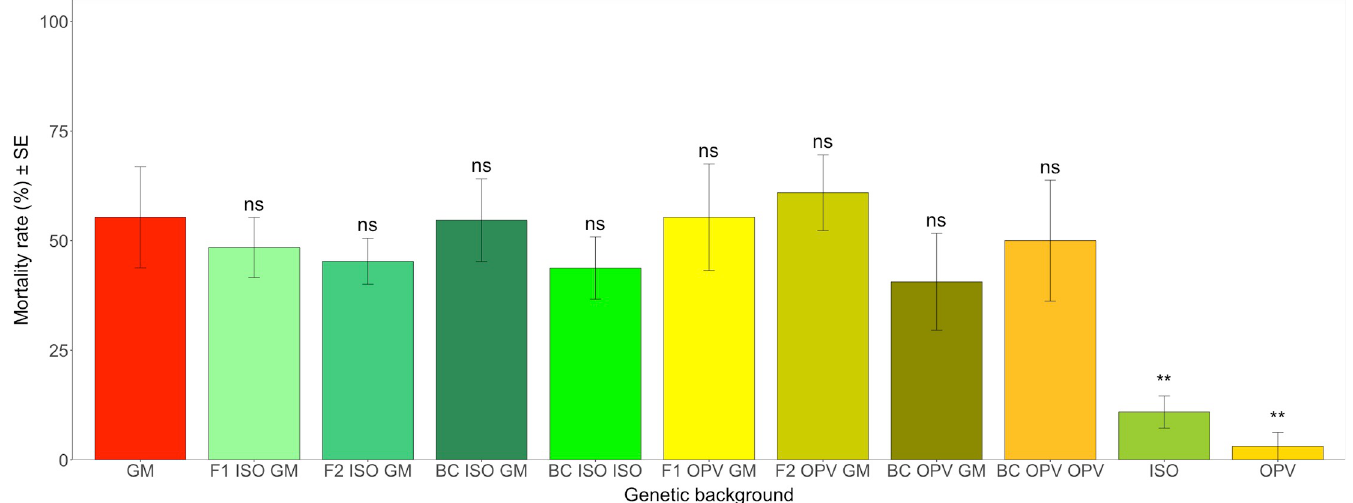
Fig 7. Mean mortality rate (%) of S . littoralis in different genetic backgrounds from South Africa. Vertical bars show mean values, with standard error ( ± SE) indicated as lines. Results of multiple comparisons of means with the group control GM parental maize (Dunnett’s method). �� P < 0.01, ns = not significant. The p- values reported were adjusted by the single-step